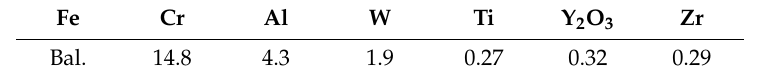
Table1. ThemeasuredchemicalcompositionsoftheODSalloys(wt.%), whereBal. isthebalancecontent. Fe Cr Al W